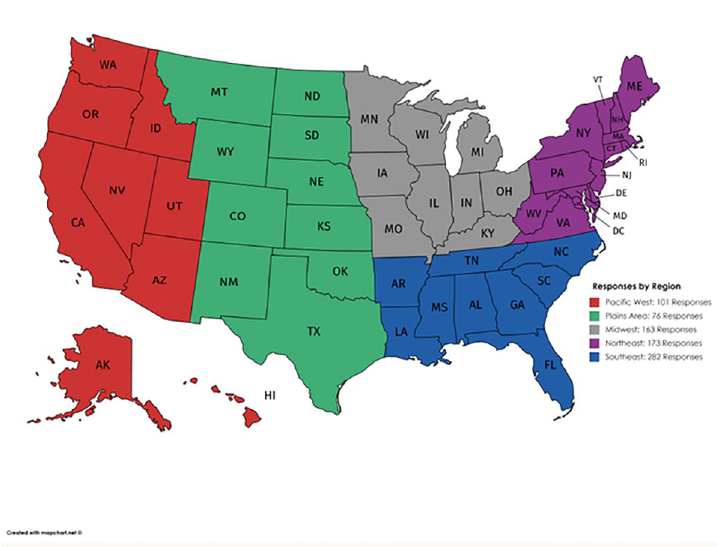
Fig 1. Responses by region. This figure illustrates the number of respondents by region. Reprinted from https:// mapchart.net/ under a CC BY license, with permission from mapchart.net original copyright (2013).